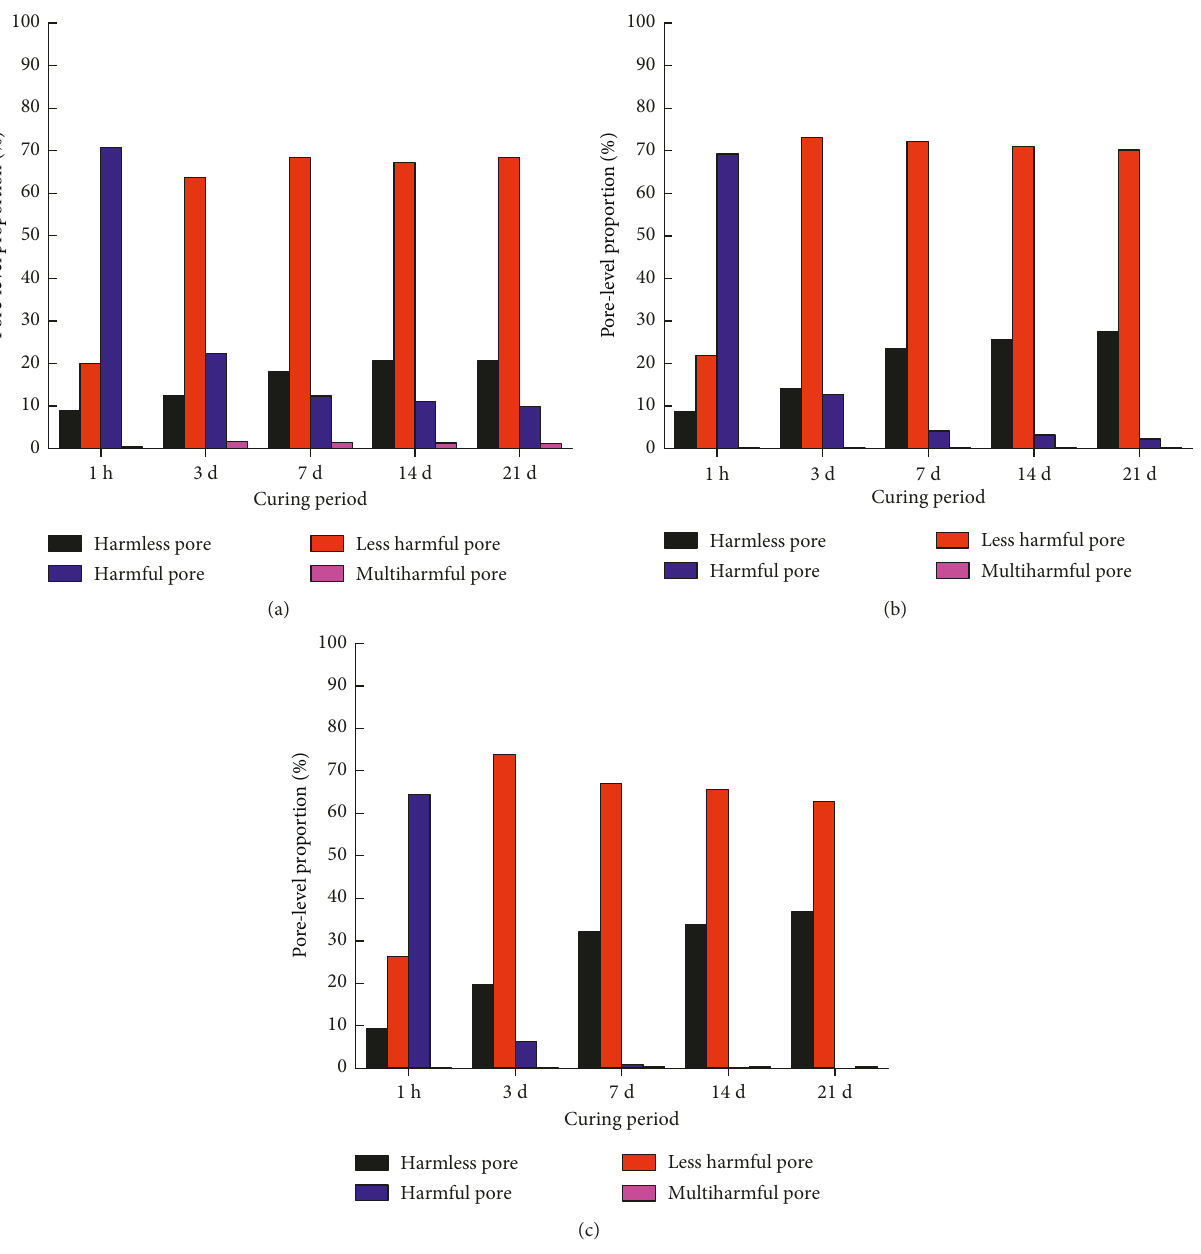
Figure 5: Pore size distributions of the filling slurries with different concentrations: (a) 56%, (b) 62%, and (c)